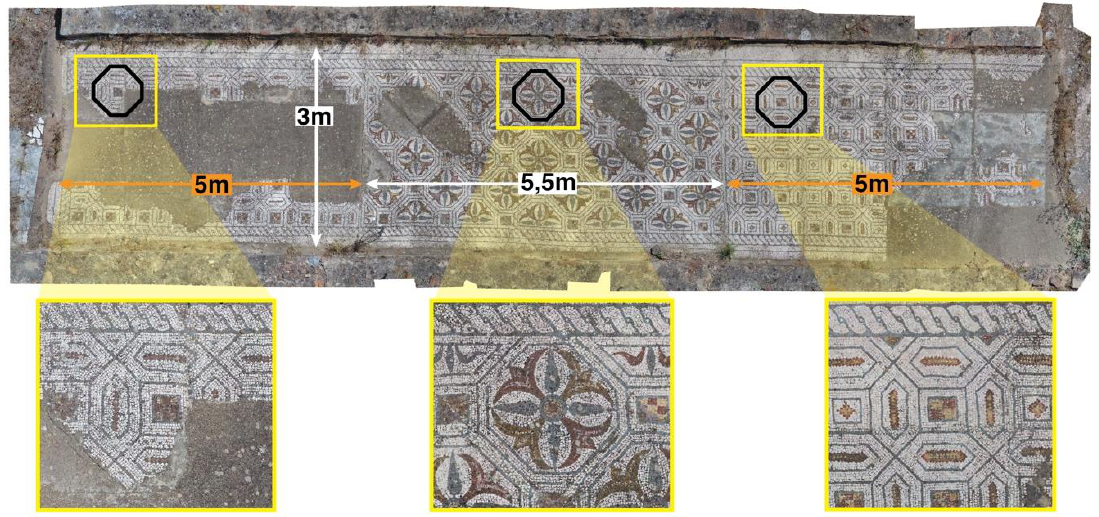
Figure 4. Photogrammetric orthomosaic of the entire studied roman mosaic (top), where the large octagons that define the geometry of the background pattern are shown. The bottom panels show a zoom in of the geometric compositions that fill the inner three sections of the mosaic.